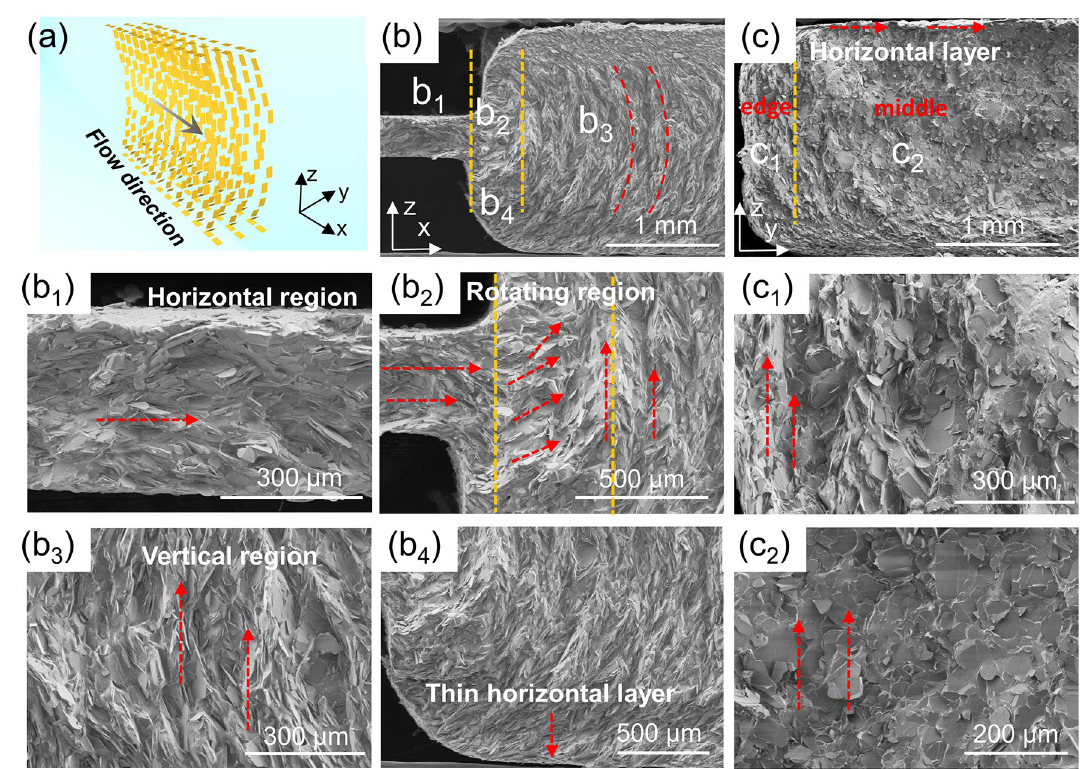
Fig. 2 The longitudinal and transverse morphologies of 60 V-BN/SG (0.2–2) strips. a Schematic of BN alignment in the expansion mold. b Longitudinal view ( x – z plane) showing the alignment rotation of BN in the expansion microchannel, divided into the horizontal region b 1 , the rotating region between two yellow lines b 2 , vertical region b 3 , the horizontal layer b 4 . c Transverse view ( z – y plane) showing alignment differ- ence of BN plane in the edge c 1 and middle area c